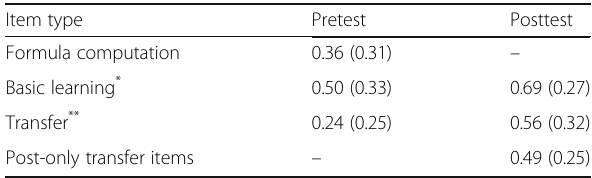
Table 5 Mean pre- and posttest learning and transfer scores on 0 – 1 scale (with